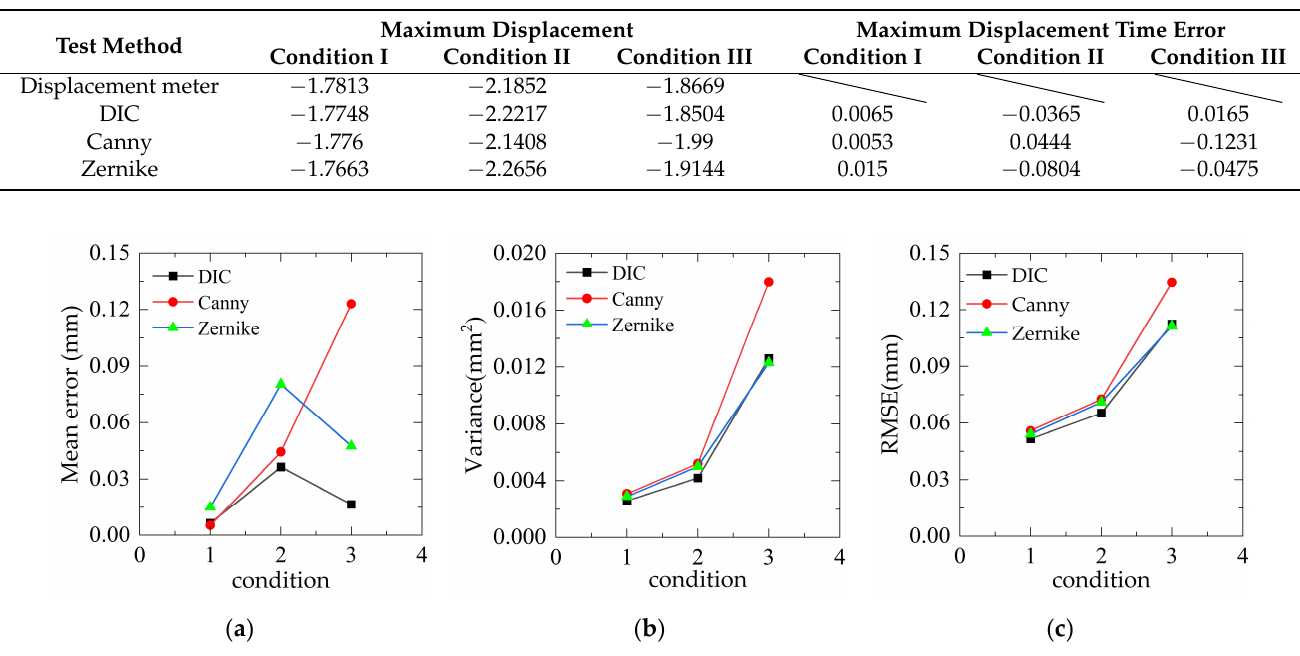
Table 2. Maximum value and error of bridge displacement.